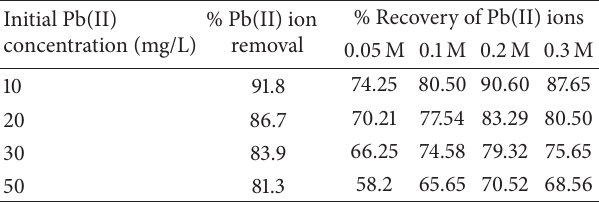
Table4:DesorptionofPb(II)ionsfromactivatedcarbonusingHCl. Initial Pb(II) concentration